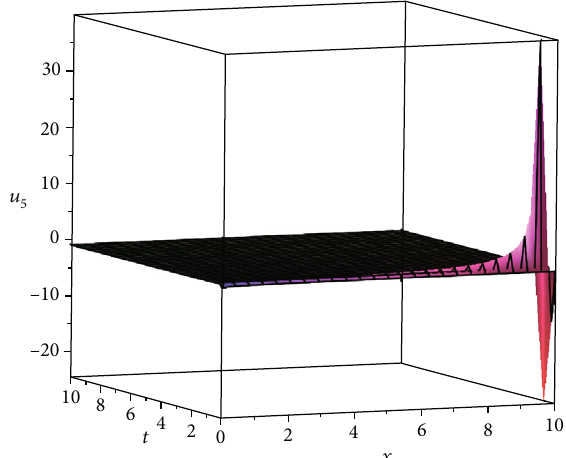
Figure 3: The solution u